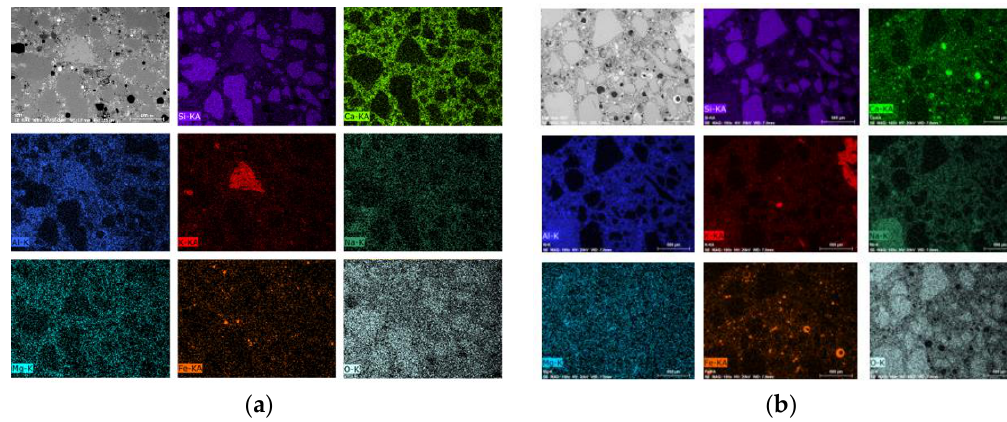
Figure 9. Mapping performed with a scanning microscope using an EDS detector, under variable vacuum conditions, magnification 100×, EHT 20kV: ( a ) mortar with GGBFS addition (WD 6.7 mm), M50/20 °C; ( b ) mortar based on FA only, M0/20 °C (WD 7.8 mm).